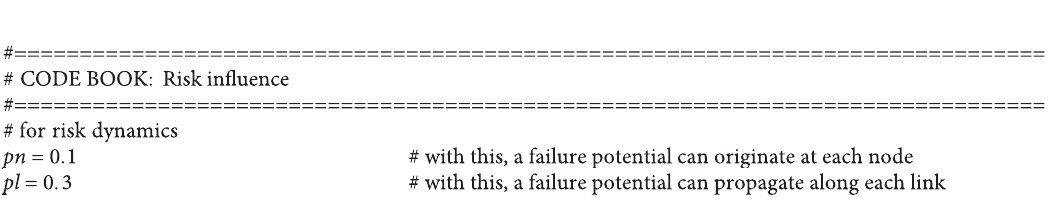
Figure 6: Code book: create centrality.